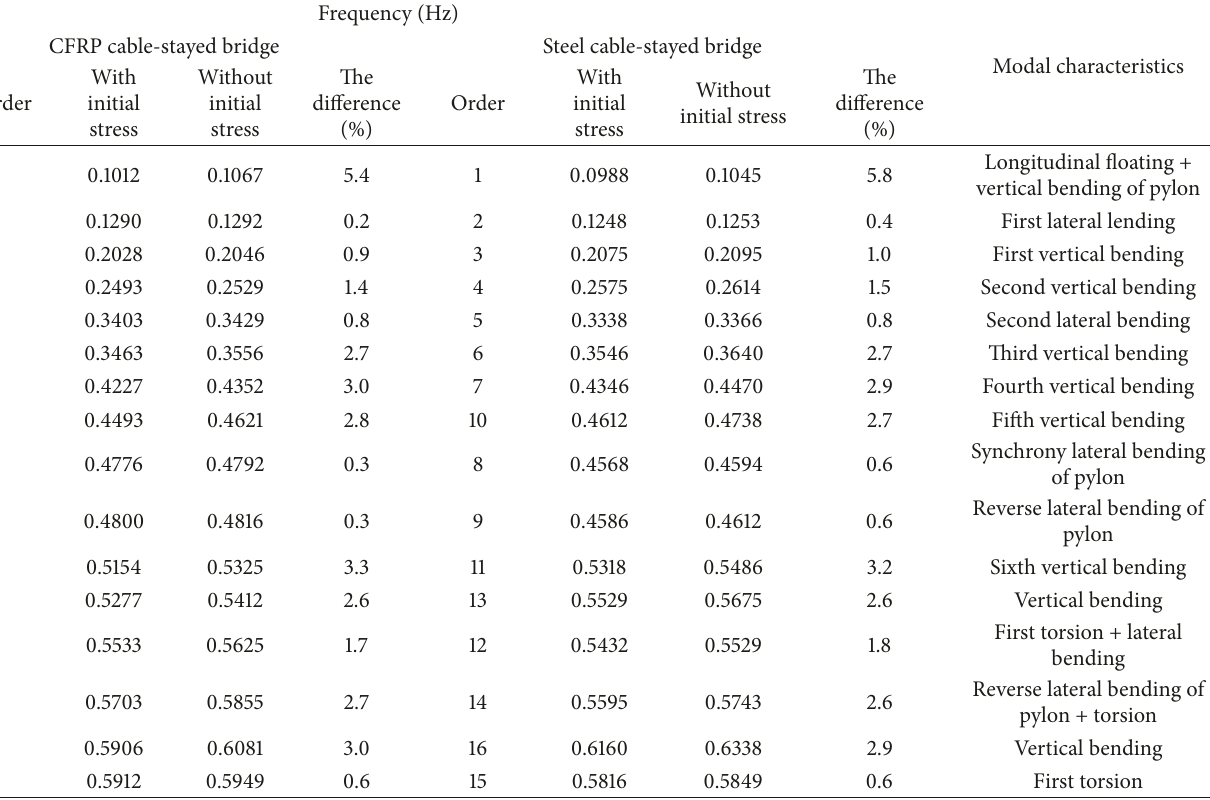
Table 5: Dynamic performance of the two cable-stayed bridges.